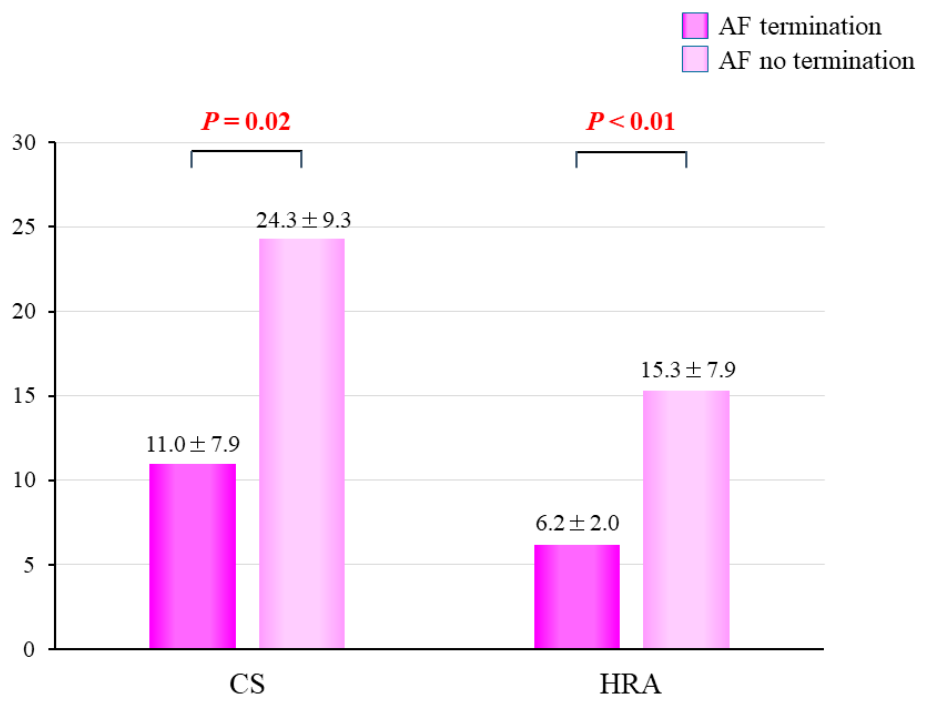
Figure 6. Baseline mean coefficient of variation at CS and HRA. AF = atrial fibrillation; Cs = coronary sinus; HRA = high right atrium.